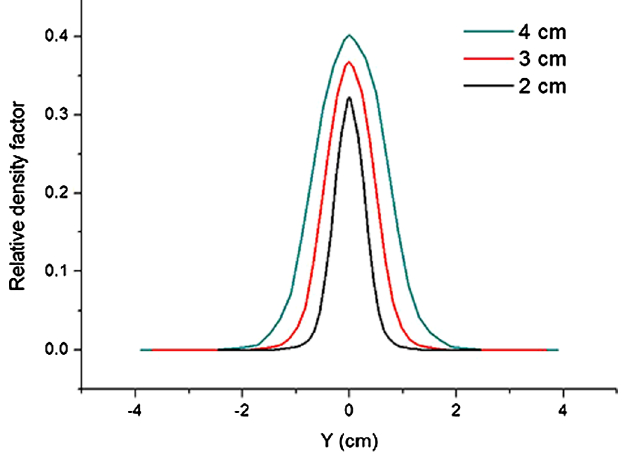
FIG. 7. Medium density (relative factor) distributions (in y direction, at x ¼ 0 height) for the grain waterfalls with 2, 3, and 4 cm target width.